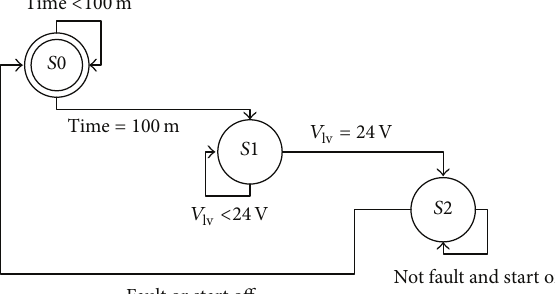
Figure 8: Boost mode controller.